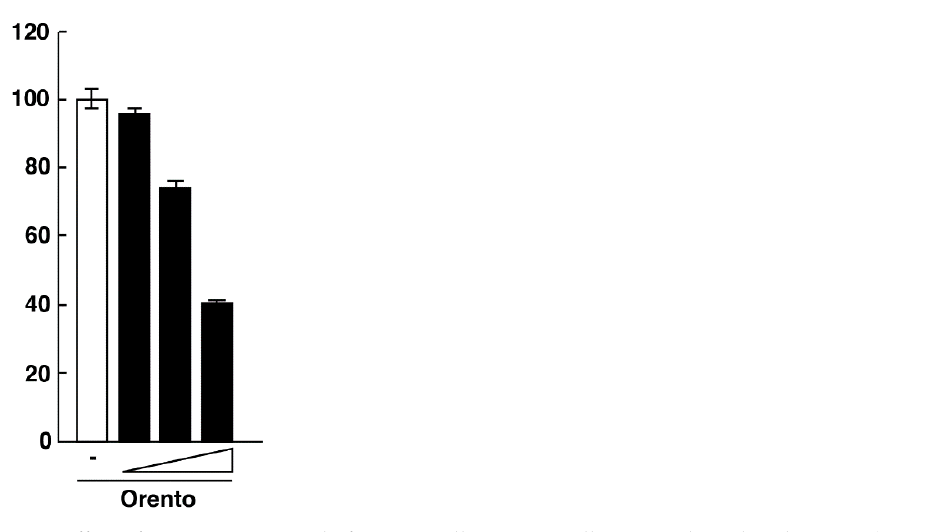
Figure 1. Effect of orento on survival of CAL27 cells. CAL27 cells were cultured with orento (10, 100, and 1000 µ g/mL) for 1 day and MTT assay was performed. Bars represent the means and range of triplicate samples.